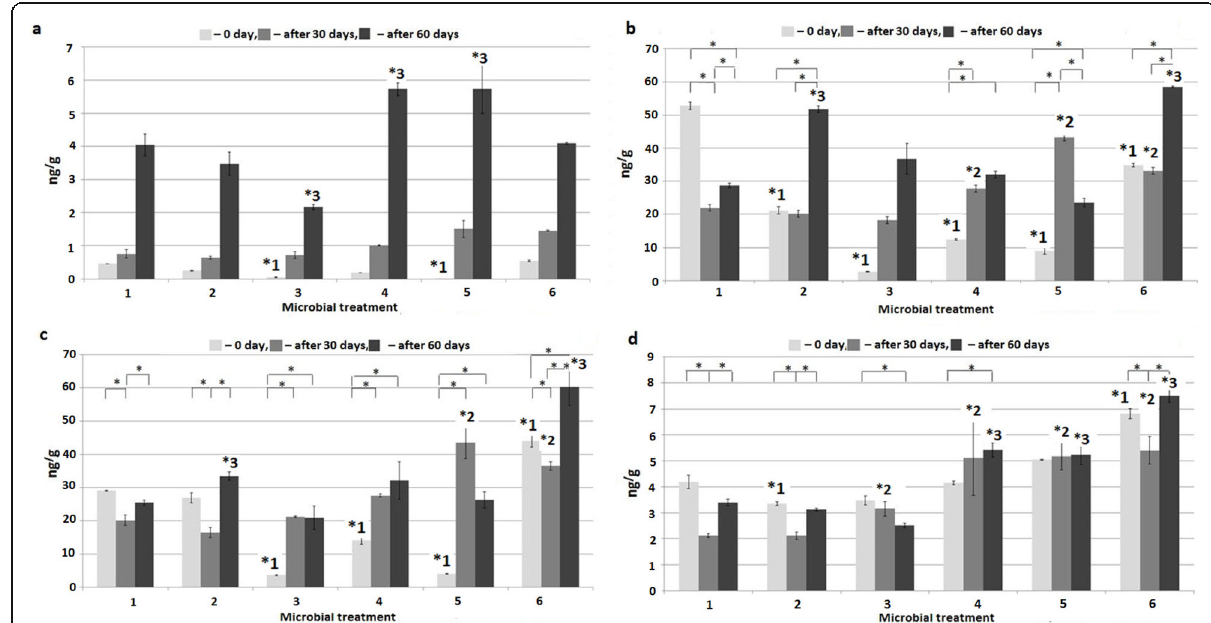
Fig. 2 Concentrations of amplified products of Gammaproteobacteria ( a ), Acidobacteria ( b ), Firmicutes ( c ) and Trichoderma ( d ) in treated soil samples at different time periods. * — significant ( P < 0.05) difference between samples at the same treatments; * 123 — significant difference from control at the same time; standard deviation is obtained from three